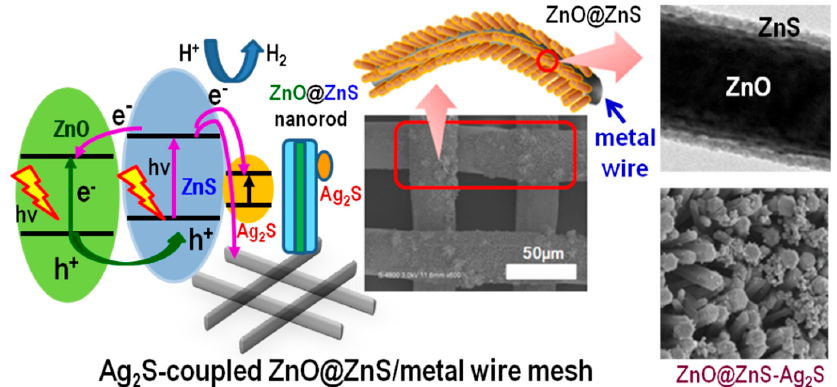
Figure 1. Morphology and a proposed mechanism of the photocatalytic H 2 production by metal wire mesh based immobilized photocatalysts with Ag 2 S-coupled ZnO@ZnS core–shell nanorods. Figure adapted from [32]. Table 3. Photocatalytic H 2 generation property of photocatalysts loaded with silver sulfide.